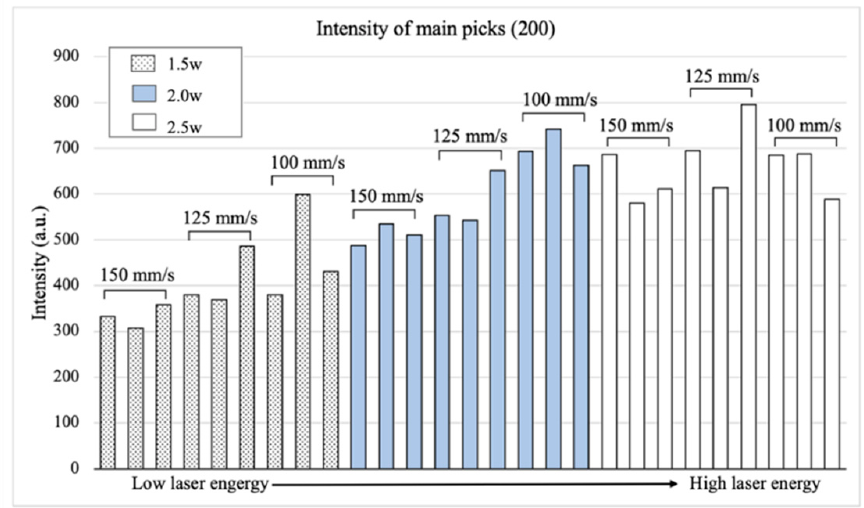
Figure 16. Intensity of main picks of all laser output parameters.